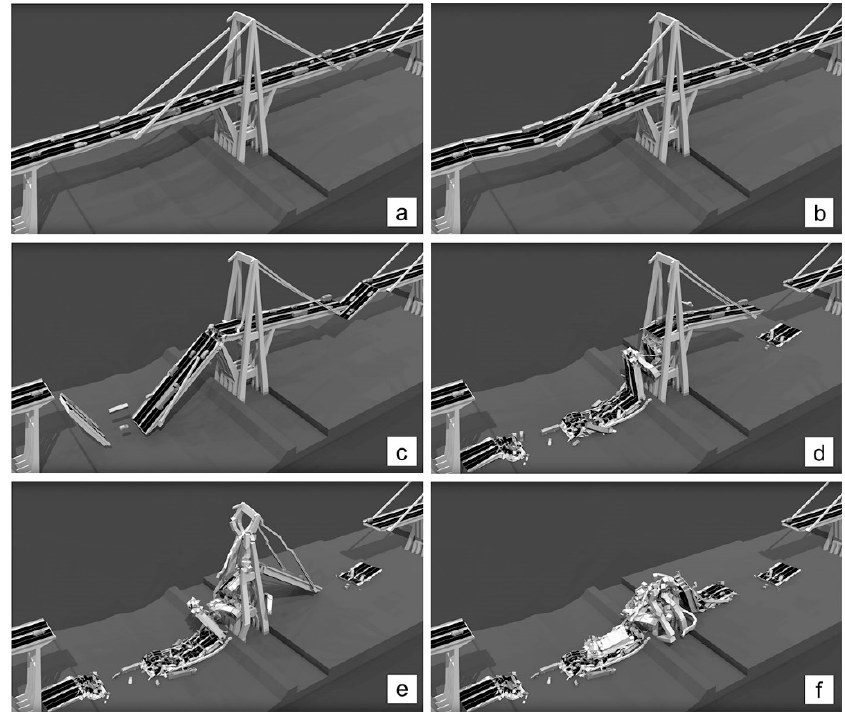
Figure 11. Fragments of the animation showing the probable course of the viaduct collapse (author of the animation: Kai Kostack, [10]).